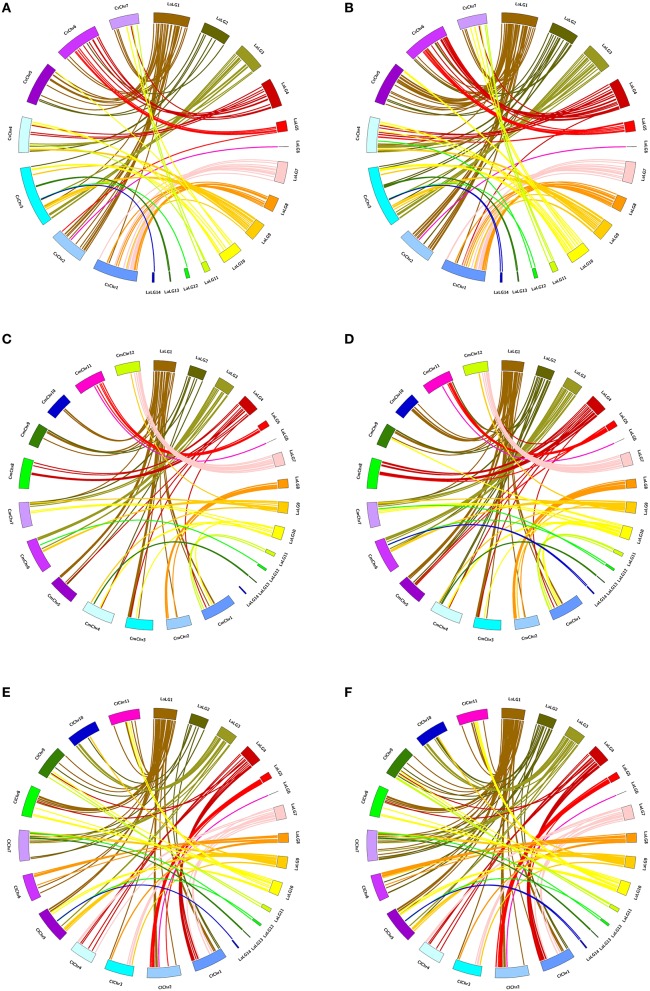
Circos illustration of the colinearity analysis between the sequences of sponge gourd EST-SSR markers and the genomic sequences of cucumber, melon and watermelon. (A) The PCR-amplified target fragments of sponge gourd EST-SSR markers–cucumber genome. (B) The Unigenes where sponge gourd EST-SSR markers located—cucumber genome. (C) The PCR-amplified target fragments of sponge gourd EST-SSR markers—melon genome. (D) The Unigenes where sponge gourd EST-SSR markers located—melon genome. (E) The PCR-amplified target fragments of sponge gourd EST-SSR markers—watermelon genome. (F) The Unigenes where sponge gourd EST-SSR markers located—watermelon genome. The sponge gourd linkage groups are denoted as LaLGs and the pseudomolecules of cucumber, watermelon and melon are represented as CsChrs, ClChrs, and CmChrs, respectively.